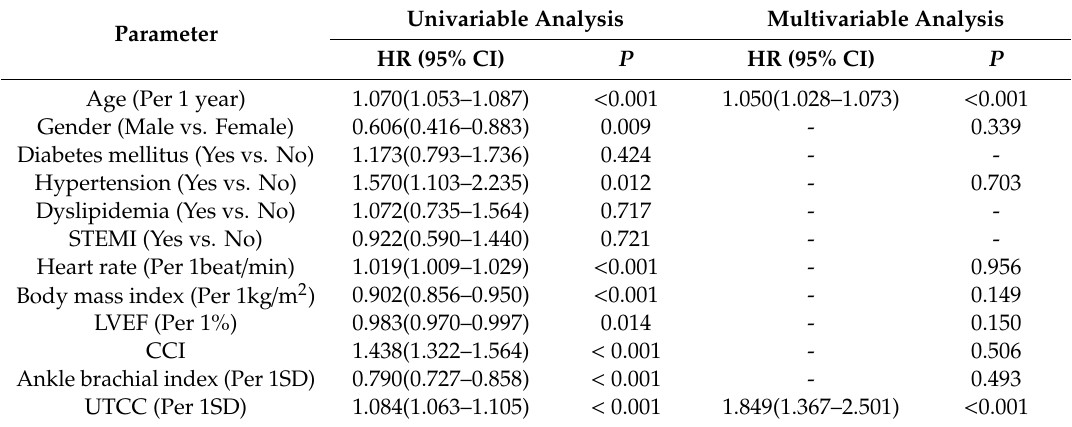
Table 3. Predictors of overall mortality using Cox proportional hazards model by univariable and multivariable analysis. Parameter